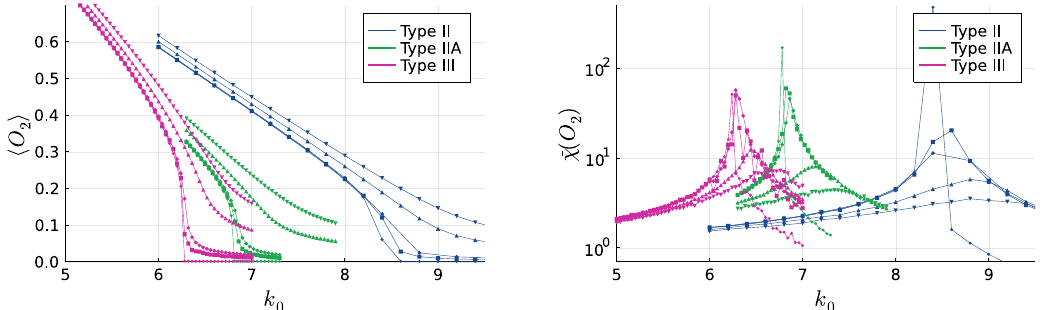
Figure 4. Left: the expectation value of the order parameter h O 2 i as a function of k 0 . Right: the normalized susceptibility ¯ χ ( O 2 ) as a function of k 0 . The color coding refers to the type II (blue), IIA (green), and III (purple) of the ensembles. The distinct marker shapes correspond to genus g = 0 ( • ) , 1 ( (cid:4) ) , 2 ( (cid:4) ) , 15 ( N ) , 30 ( H ) . The thin lines interpolate between the data points as a guide to the eye. Error bars are smaller than dot size, except for the susceptibilities near the peaks, where they grow larger, but we omit them for